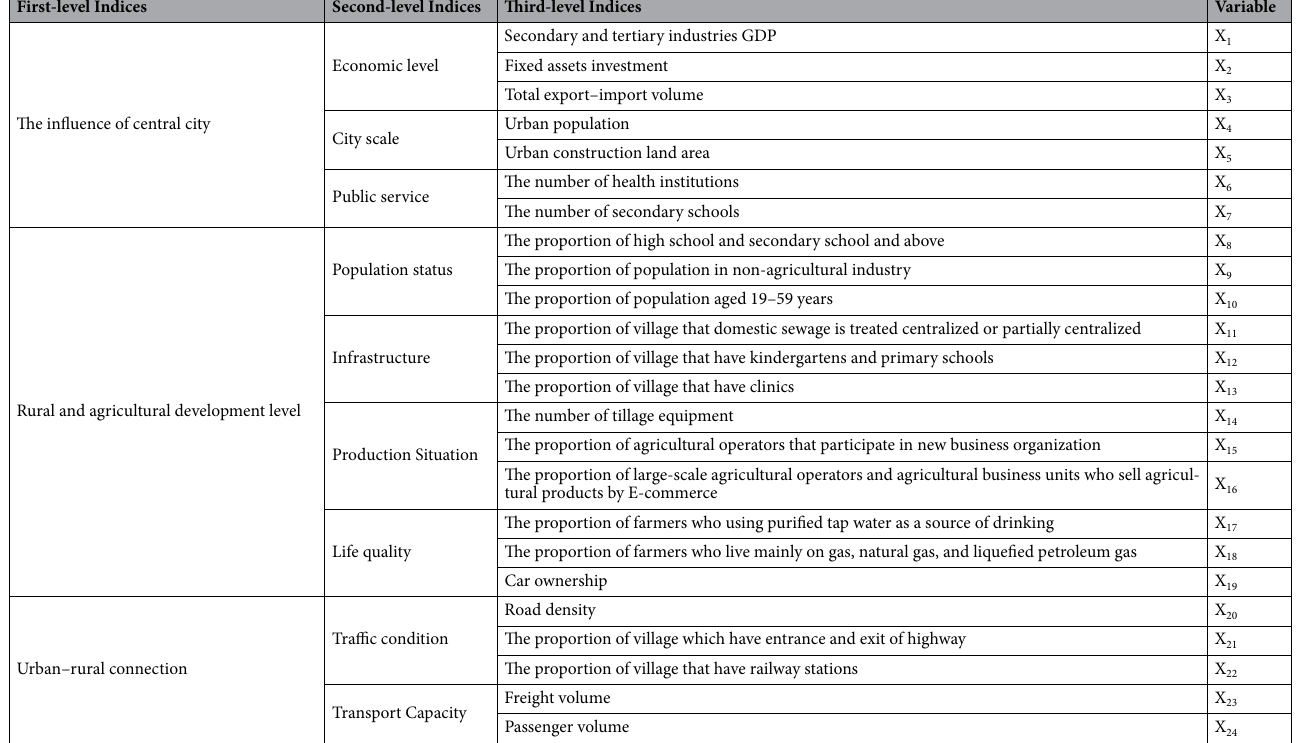
Table 3. Influence index of urban–rural integrated level of Shandong province.